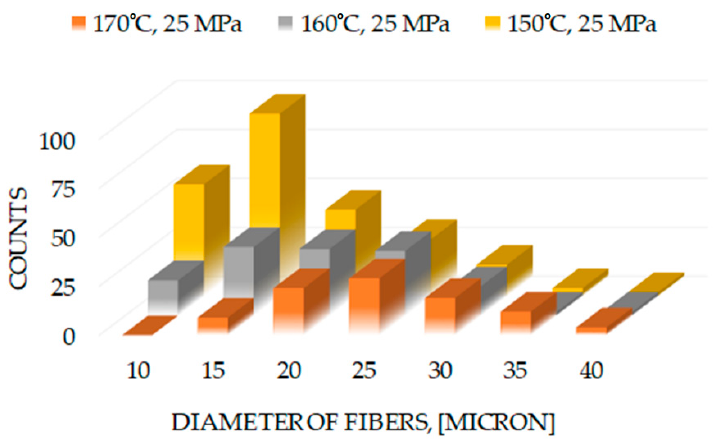
Figure 12. The histograms of fiber size distributions for samples with different preparation condi- tions.